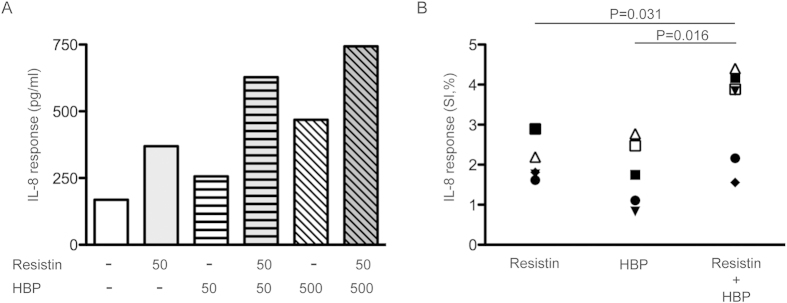
HBP and resistin induce a significant inflammatory response in vitro.PBMCs of healthy donors were stimulated with different combinations of HBP (50 or 500 ng/ml) and resistin (50 ng/ml) alone, or the combination of the two proteins. Luminex analysis of IL-8 levels of the cell culture supernatants was performed. (A) Result of one experiment using cells from one donor. (B) Result of six donors stimulated with HBP (500 ng/ml) and resistin (50 ng/ml), alone or combined, are shown; each donor indicated with a different symbol. IL-8 responses are here shown in stimulation index (SI, %), were the stimulated value is divided with the unstimulated value. Mann-Whitney U test was used for comparison between groups and differences are shown in p values.